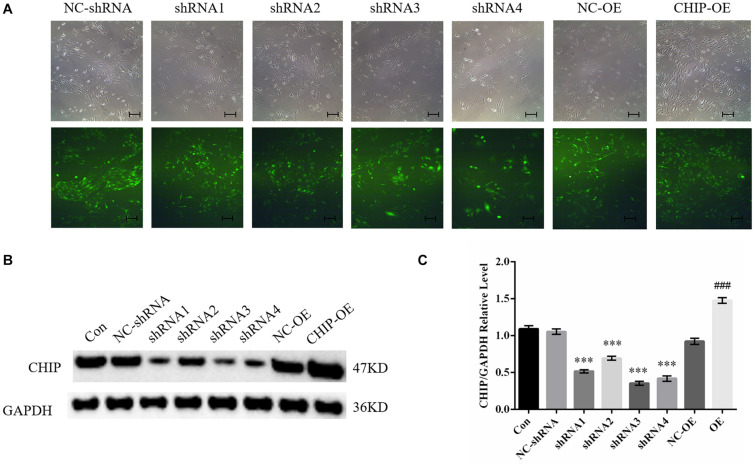
C terminus of Hsc70-interacting protein (CHIP) overexpression and knockdown in bEnd.3 cells. (A) PCR-amplified mouse CHIP and shRNA1, shRNA2, shRNA3, and shRNA4 were cloned into lentivirus expression vectors, which contained green fluorescent protein to indicate transfection efficiency. After 48 h, the transfection efficiency was observed using fluorescence microscope. NC represented non-coding control plasmid. (B) Protein level of CHIP after overexpression and interference was tested by immunoblotting. (C) CHIP/glyceraldehyde-3-phosphate dehydrogenase relative level after overexpression and interference. ∗∗∗p < 0.001 vs. the NC-shRNA, ###p < 0.001 vs. the NC-OE, Scale bars: 50 μm.